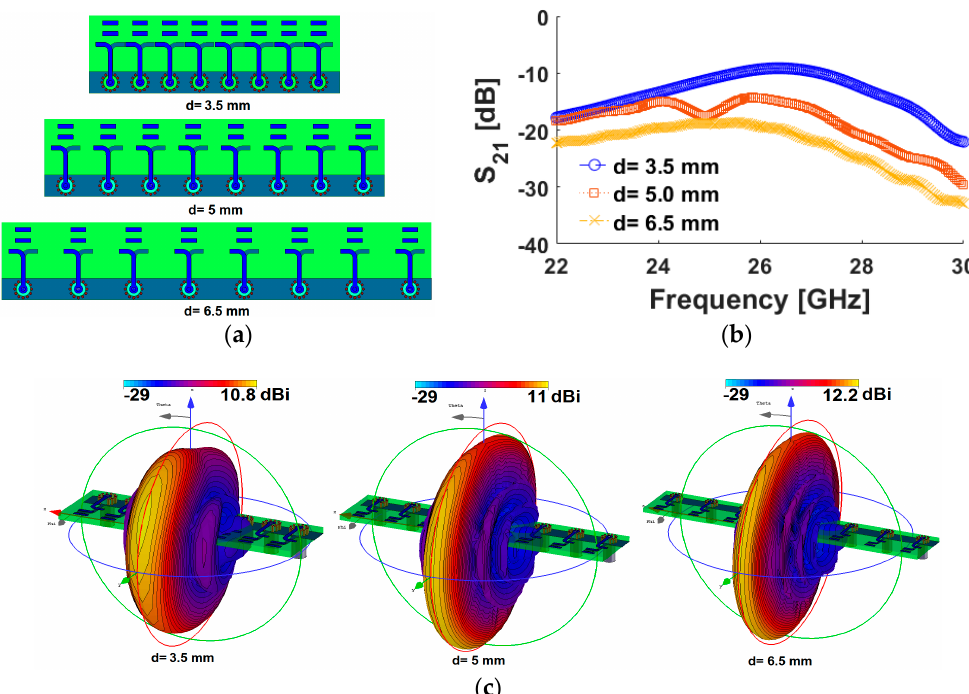
Figure 10. ( a ) Configurations, ( b ) S 21 , and ( c ) radiation beams of the linear array for different vales of d .